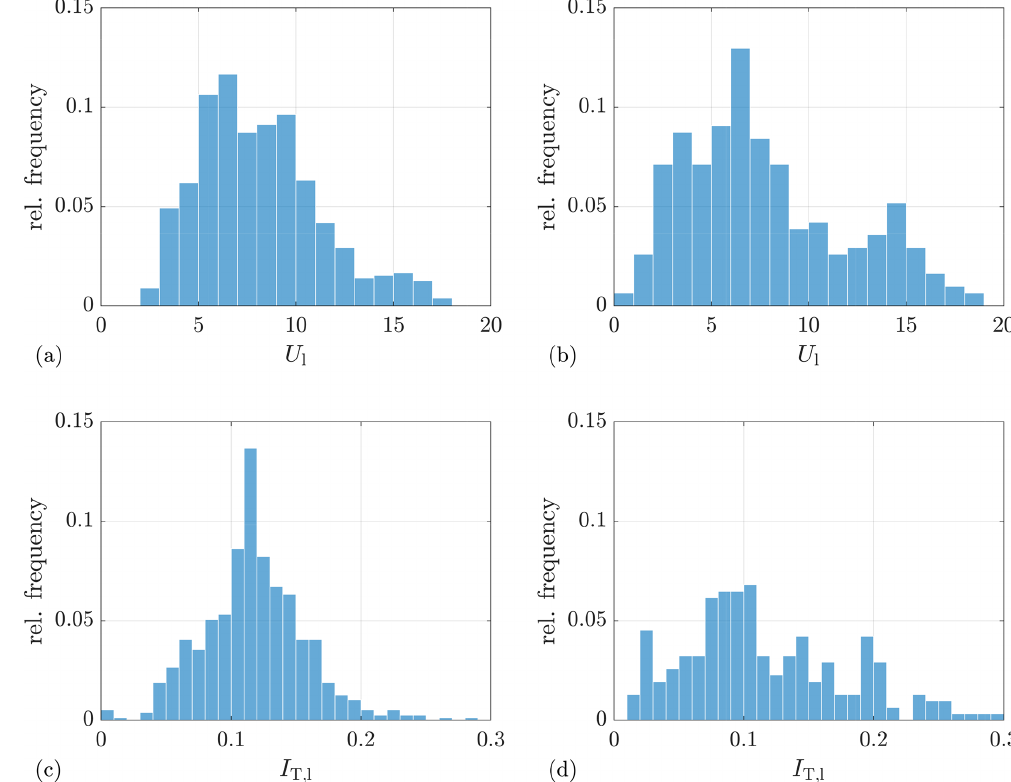
Figure A1. Distribution of lidar-measured mean wind speed and turbulence intensity for the selected period. (a, c) Lidar Complex, from the range gate at 163.5m. (b, d) ParkCast, from the range gate at